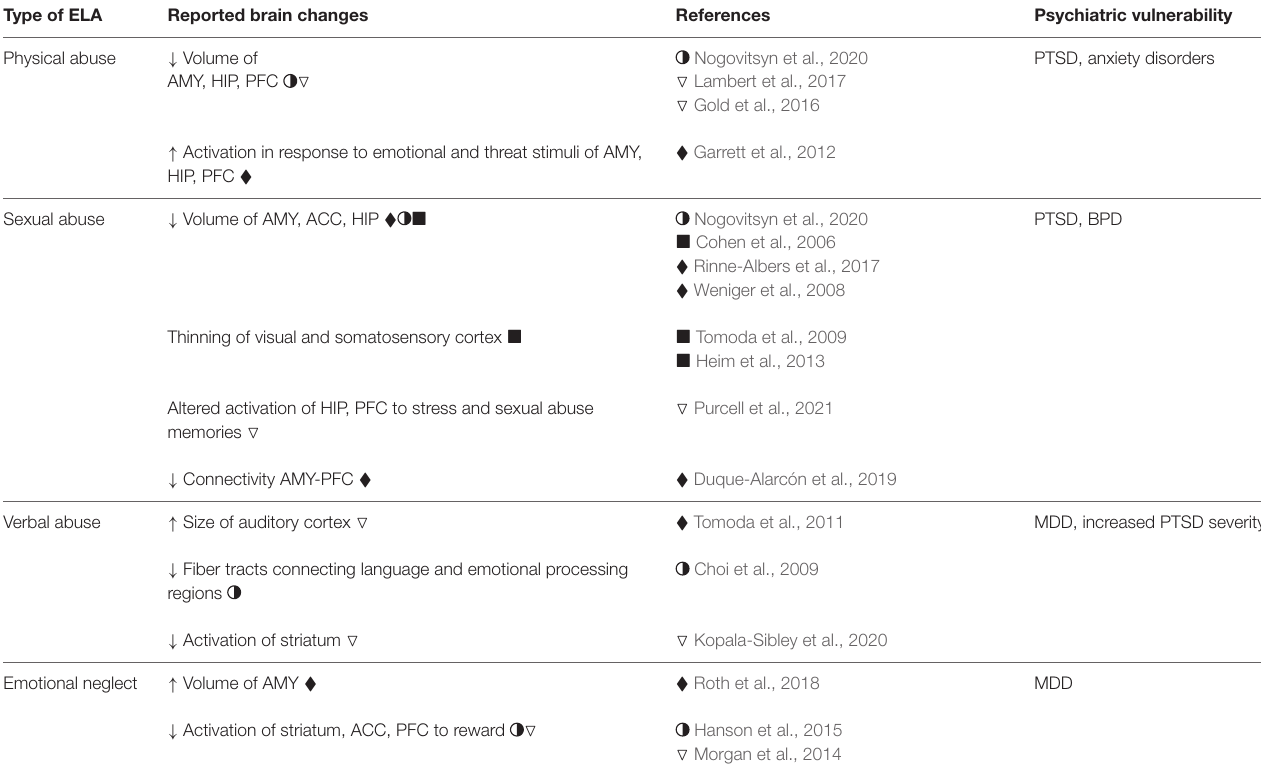
TABLE 1 | Brain changes and neuropsychiatric disorders associated with different types of ELA in humans. Type of ELA